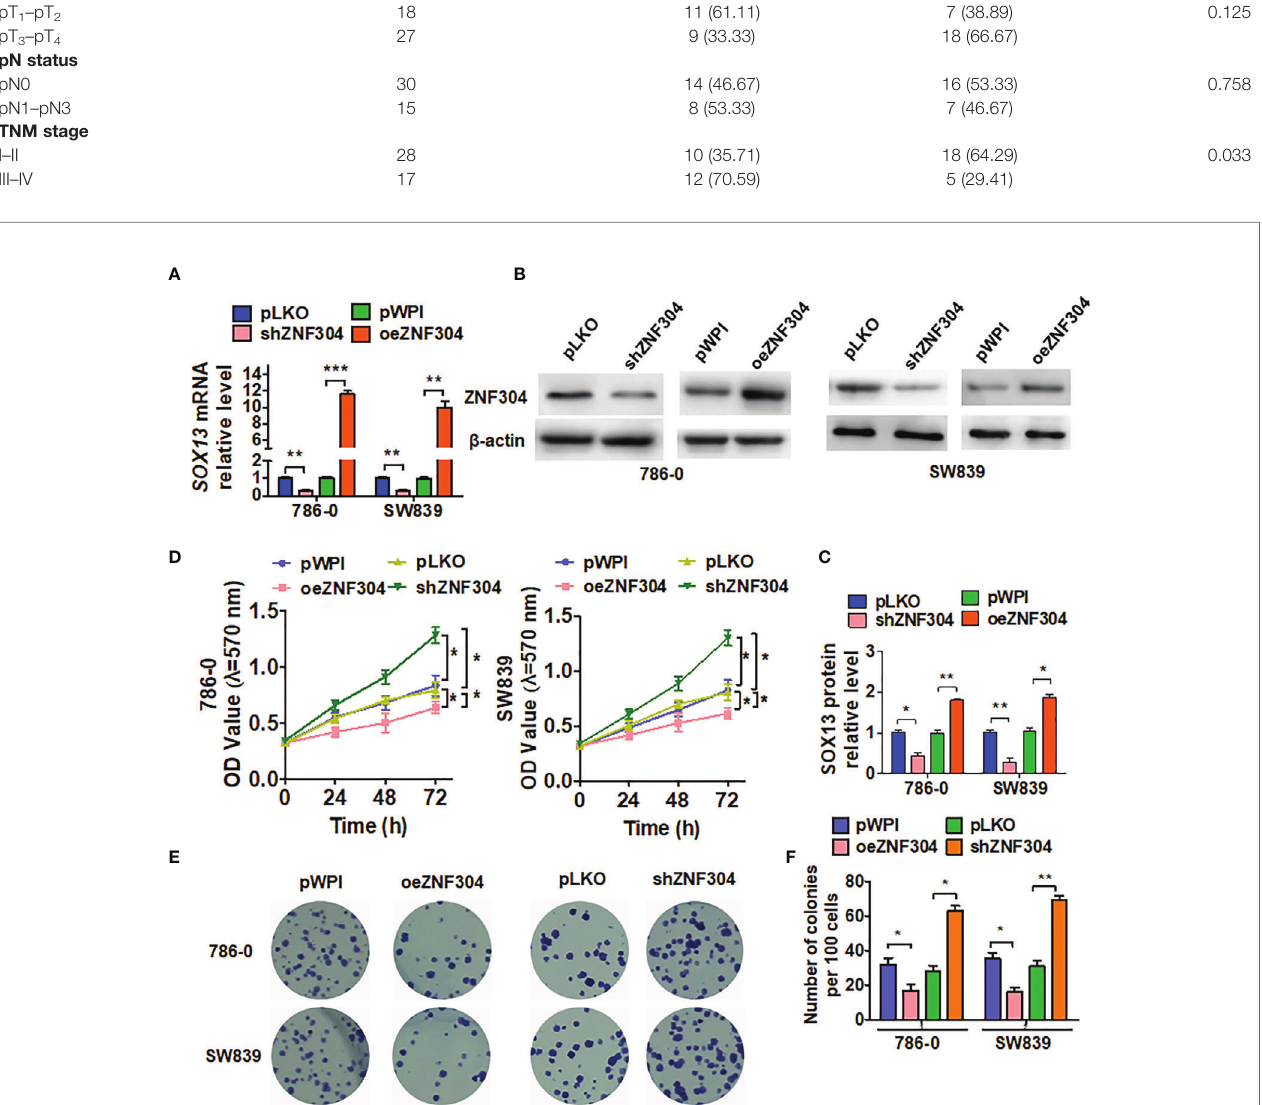
FIGURE 2 | ZNF304 inhibits ccRCC cell growth. (A) The shZNF304, oeZNF304 and control vectors were transfected to SW839 and 786-0 cell, and then qRT-PCR was used to examine the mRNA level of ZNF304. (B) SW839 and 786-0 cells were transfected as in (A) , and the protein level ZNF304 was measured by Western blot. (C) Quantitative analysis of (B) . (D – F) Cells were transfected as in (A) , and cell viability was examined by MTT (D) and colony formation assays (E, F) . All data are from three independent experiments and expressed as the mean ± SEM. *P < 0.05, **P < 0.01, ***P < 0.001 vs. the corresponding